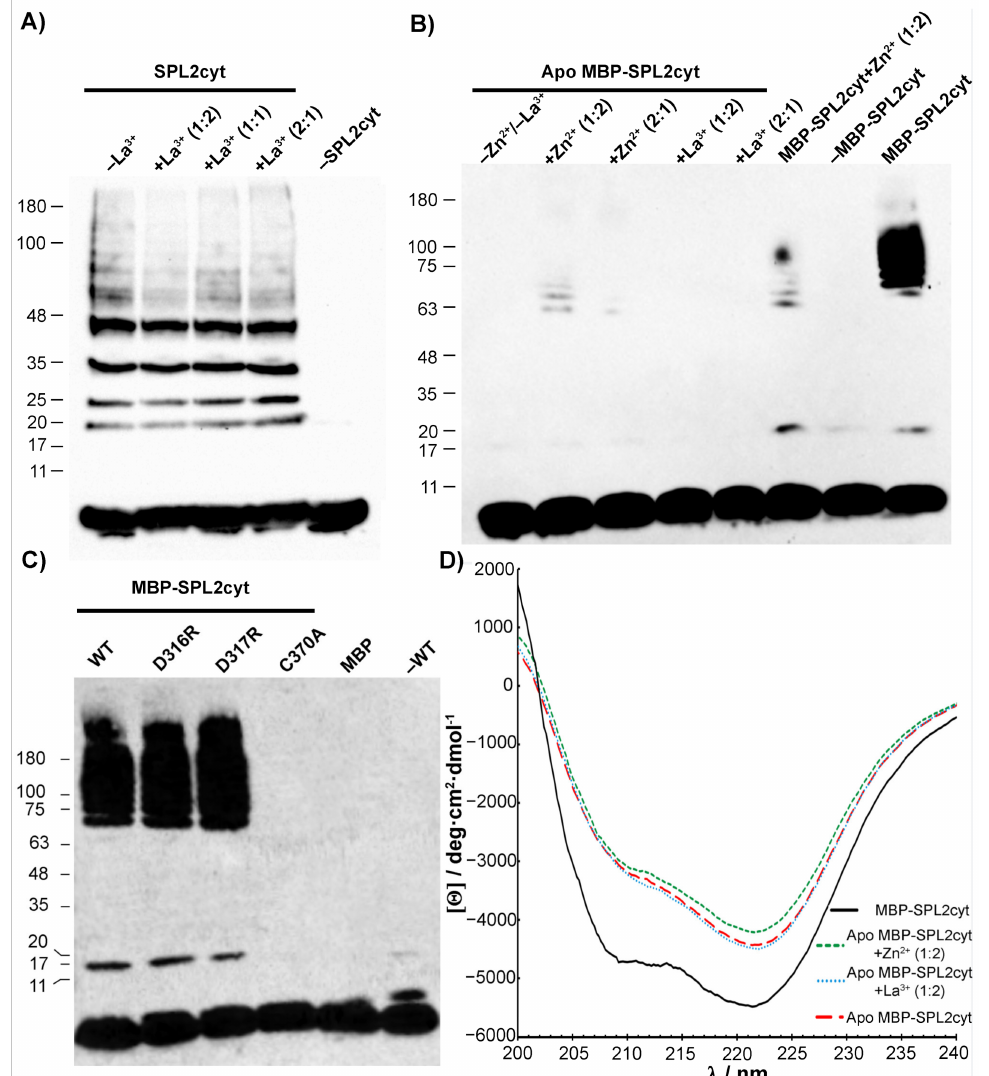
Figure 8. Analysis of SPL2cyt and MBP-SPL2cyt auto-ubiquitination activity in vitro. ( A ) Enzymatic assay of SPL2cyt in the absence or presence of La 3+ at indicated molar ratios. ( B ) Activity of zinc-free (apo) MBP-SPL2cyt after incubation with Zn or La ions. For comparison of enzymatic activity, holo MBP-SPL2cyt is also shown. ( C ) Effects of indicated mutations in the putative LBT region of MBP-SPL2cyt (D316R and D317R) and RING (C370A) on auto-ubiquitination activity. Wild-type MBP-SPL2cyt protein (WT) is shown for comparison. All Western blots were analyzed with anti-ubiquitin antibodies to detect free ubiquitin and polyubiquitination products. ( D ) CD spectra and structural changes in SPL2cyt upon removal of Zn 2+ and subsequent incubation with either Zn or La